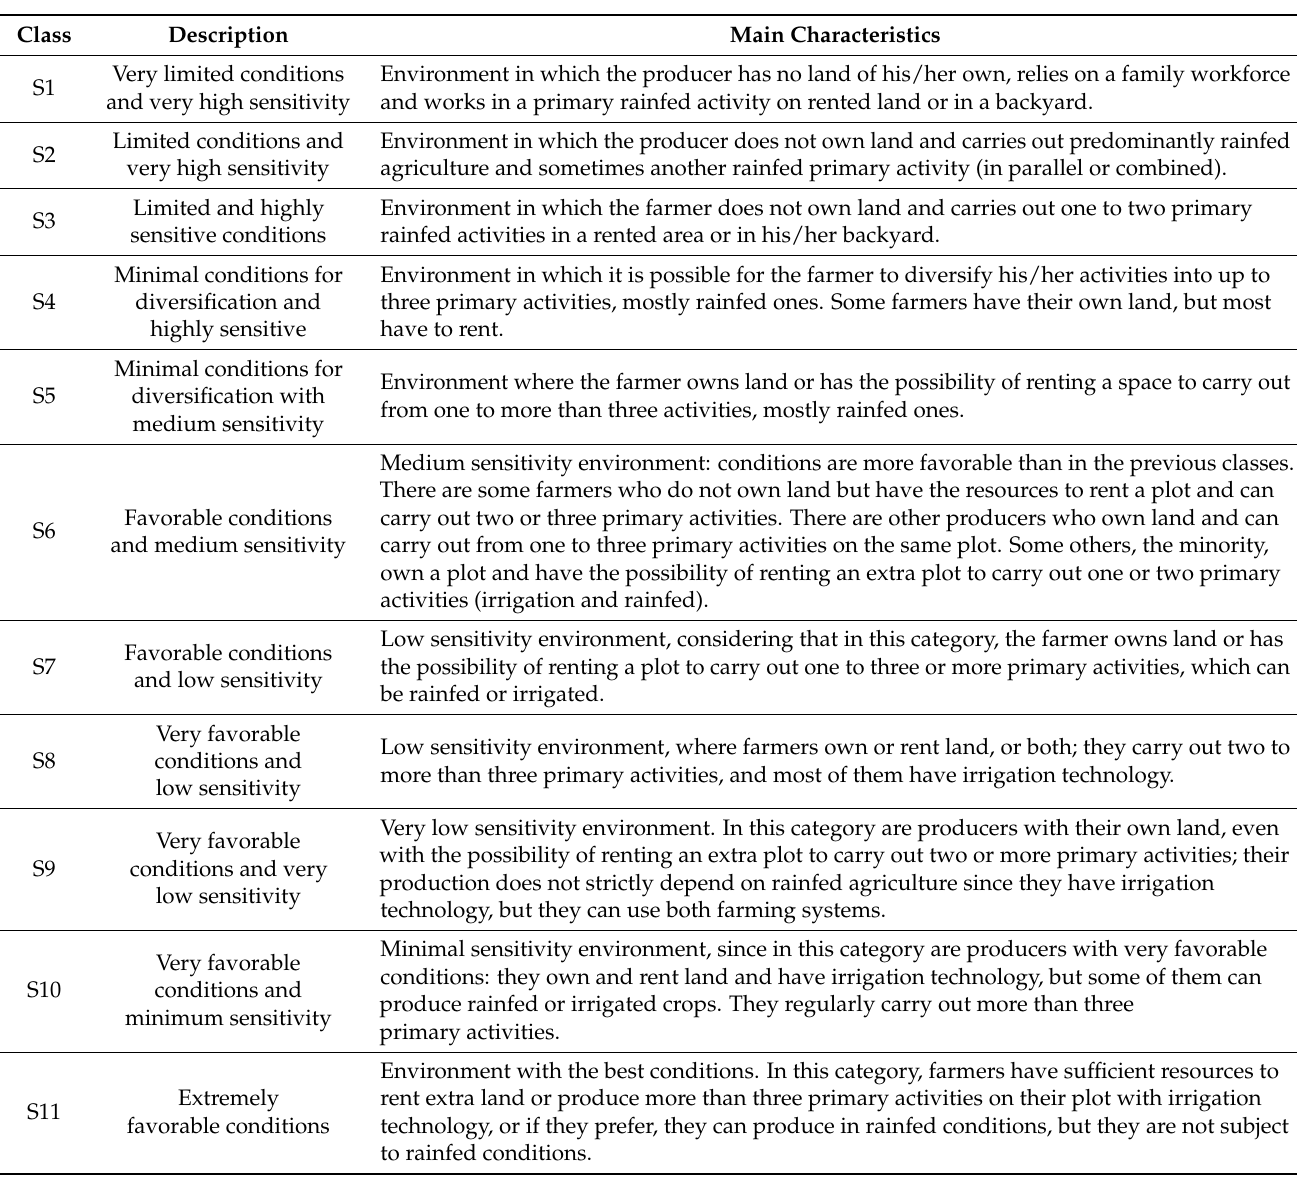
Table 4. Main characteristics of the eleven types of producer sensitivity identified in this